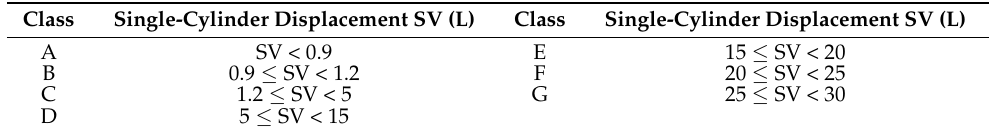
Table 5. Single-cylinder displacement